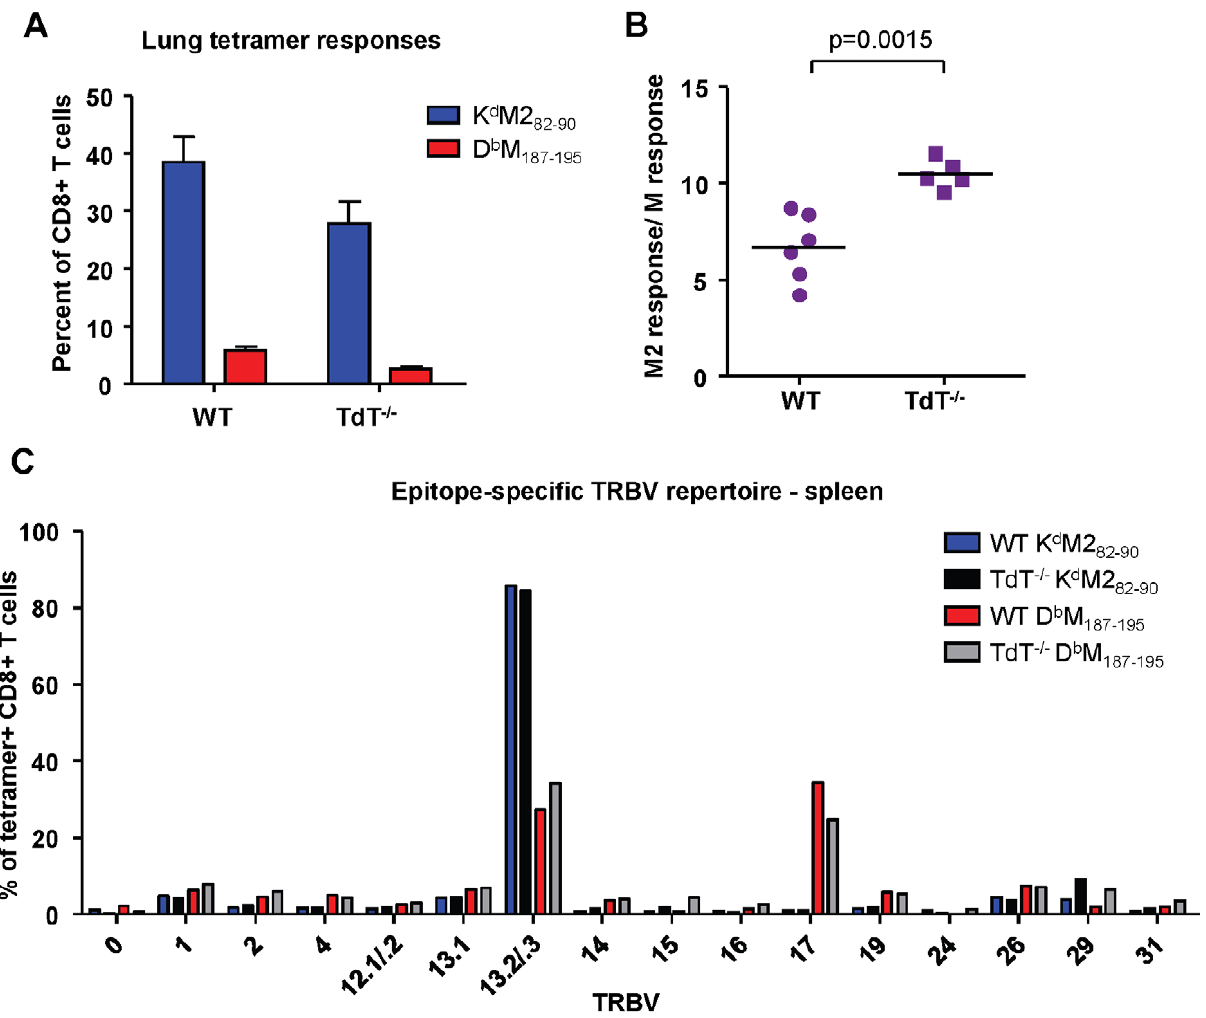
Figure 7. Epitope-specific CD8 + T cell responses in wild-type and TdT -/- adult CB6F1 mice. (A) K d M2 82-90 and D b M 187-195 tetramer-positive CD3 + CD8 + in the lungs at day 7 post-infection of wild-type (WT) and TdT deficient (TdT -/- ) CB6F1 mice. (B) Epitope-specific CD8 + T cell response ratios in infected WT and TdT -/- mice. (C) TCR V b antibody screening of pooled tetramer-positive CD8 + T cells from the spleen of infected WT and TdT -/- mice (IMGT nomenclature). Data in panels (A) and (B) are representative of two independent experiments with 5-6 mice/group. Error bars represent the